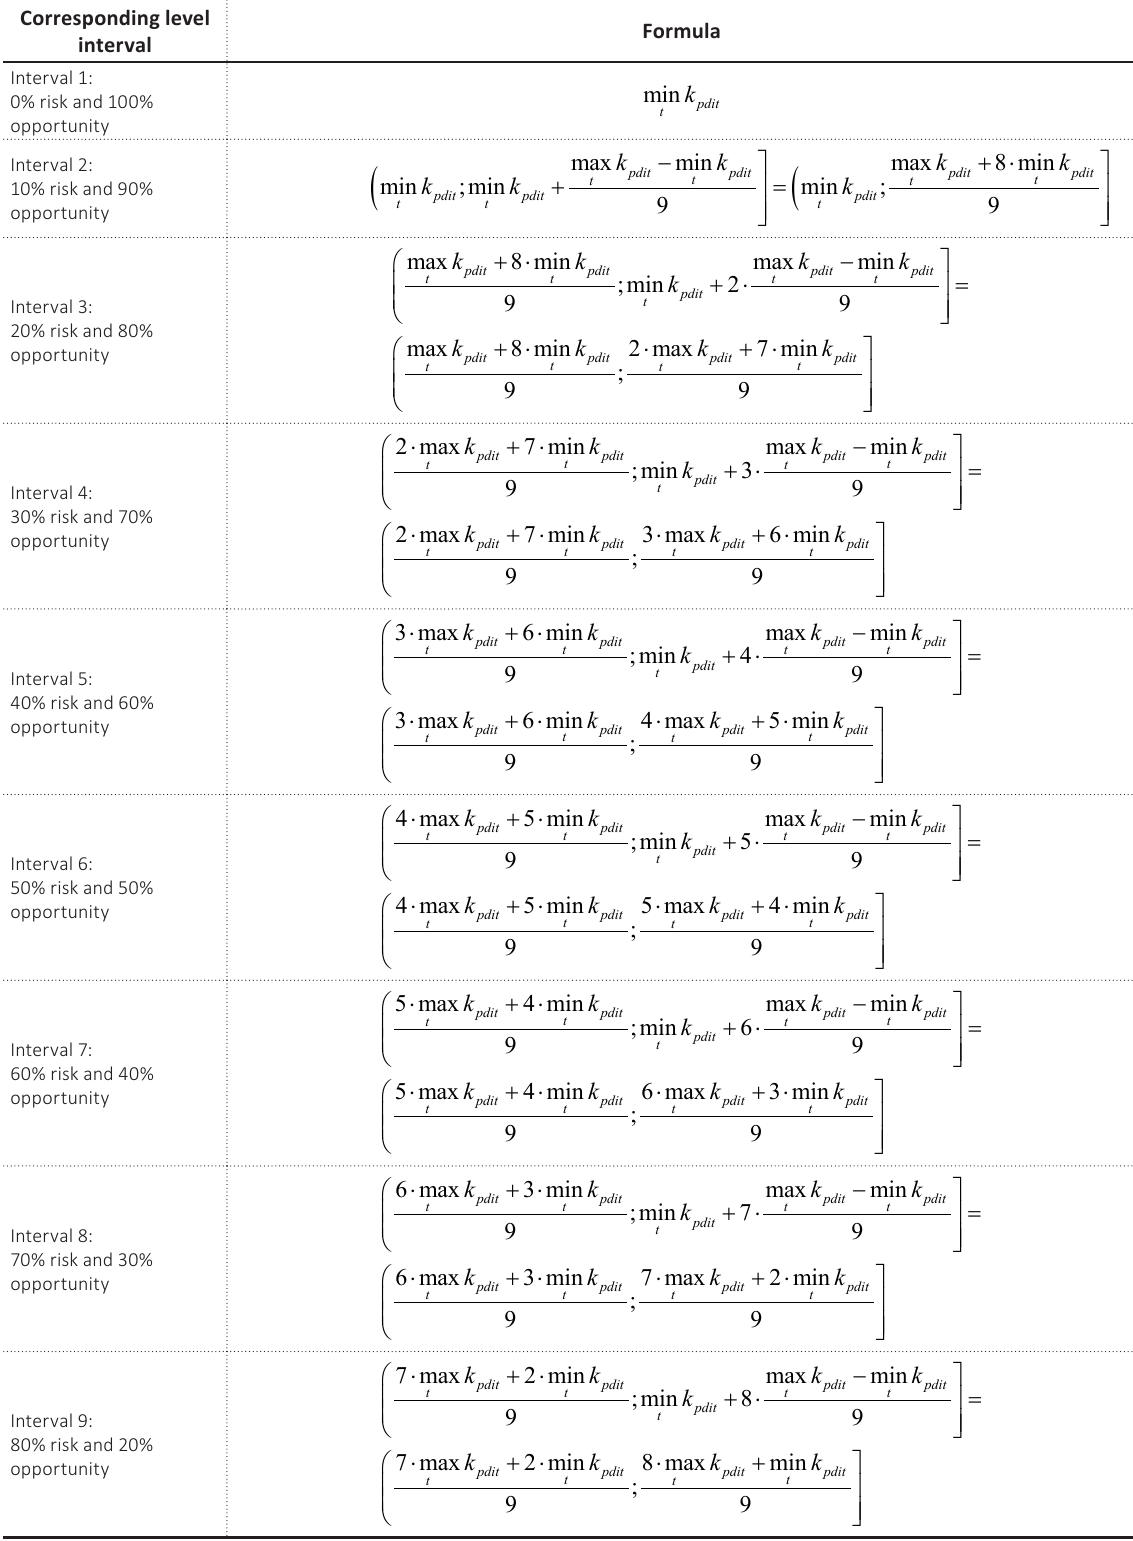
Table A1. Formulas of a fuzzy-logic approach to assessing indicators in terms of the risk of their impact on the overall level of financial security Corresponding level